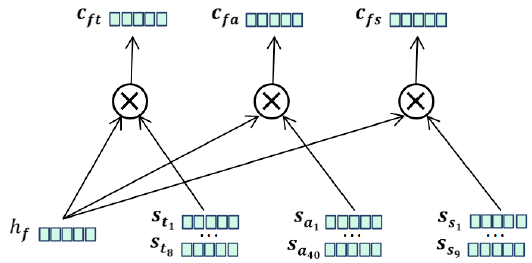
Figure 7. Framework of attention layer.